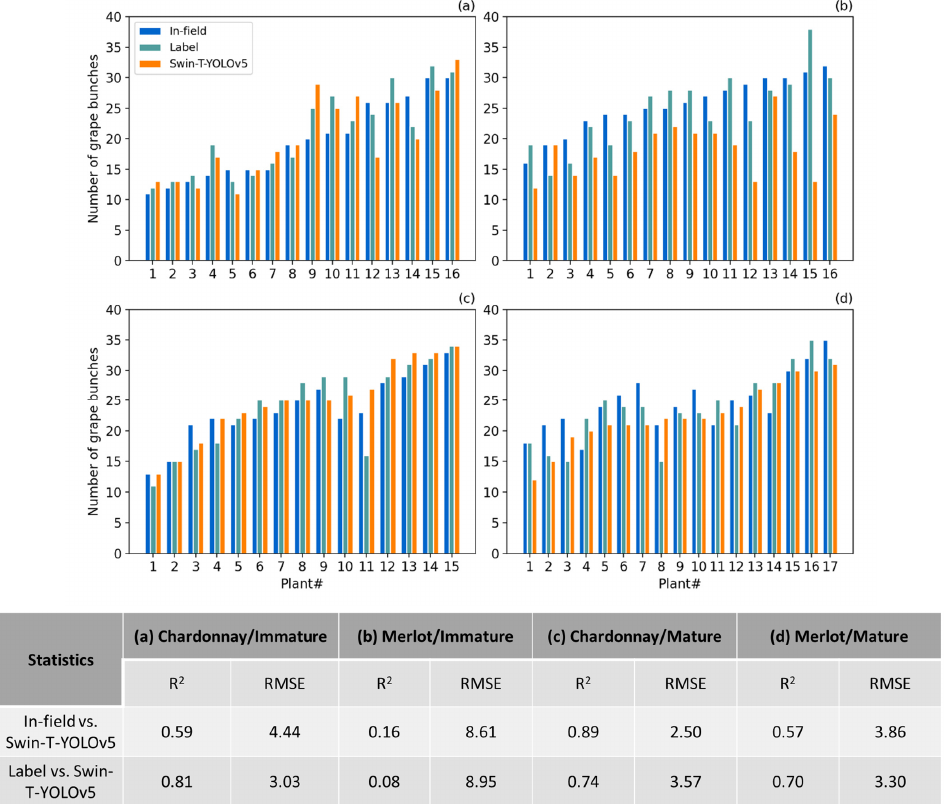
Figure 7. The number of grape bunches comparison between in-field manual counting (gTruth), manual label, and detection using Swin-transformer-YOLOv5 (Swin-T-YOLOv5) for ( a , b ) immature and ( c , d ) mature berries with Chardonnay (left) and Merlot (right). RMSE refers to root mean square error. Plant# refers to the number of plants.